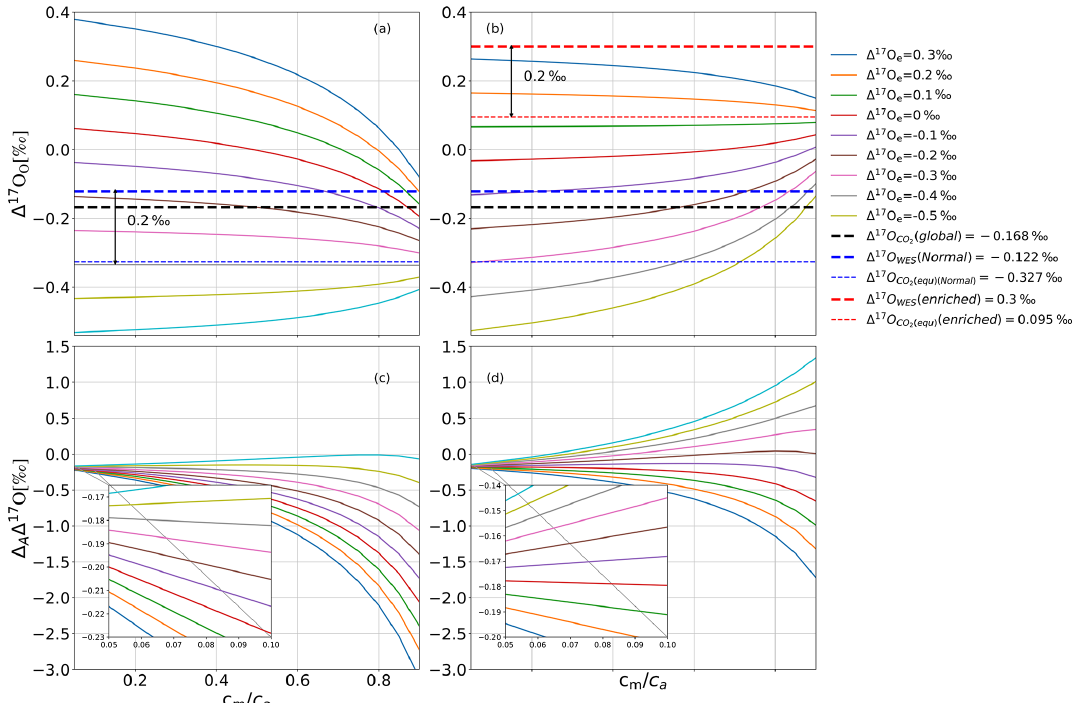
Figure 5. (a, b) (cid:49) 17 O a as a function of c m /c a for various values of (cid:49) 17 O e (see legend) for (cid:49) 17 O wes = − 0 . 122‰ in (a) and (cid:49) 17 O wes = 0 . 300‰ in (b) . Panels (c, d) show the corresponding values for (cid:49) A (cid:49) 17 O. (cid:49) 17 O global is the global average (cid:49) 17 O value for atmospheric CO 2 (Koren et al., 2019). When (cid:49) 17 O of CO 2 entering the cuvette is approximately 0.2‰ lower than the (cid:49) 17 O of leaf water at the CO 2 − H 2 O exchange site, (cid:49) 17 O of the CO 2 leaving the cuvette does not change when the c m /c a ratio varies.